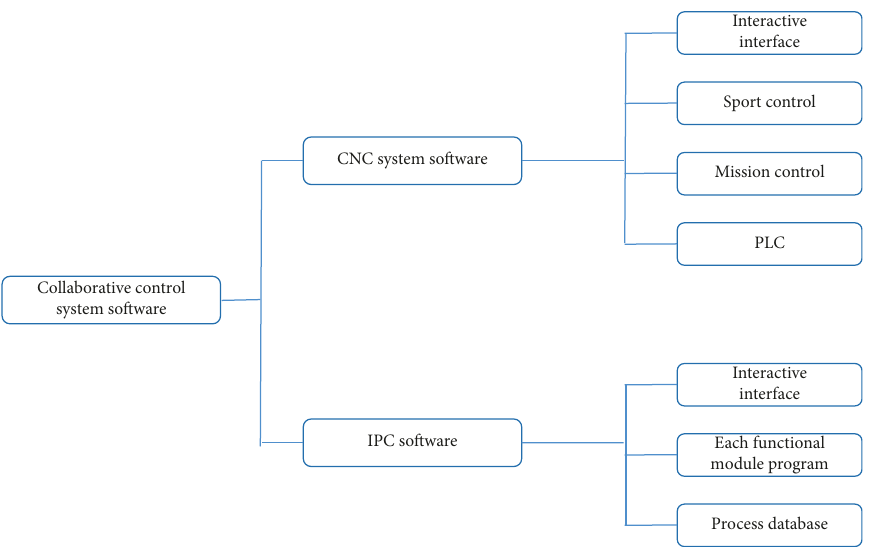
Figure 8: Overall design structure diagram of collaborative control system